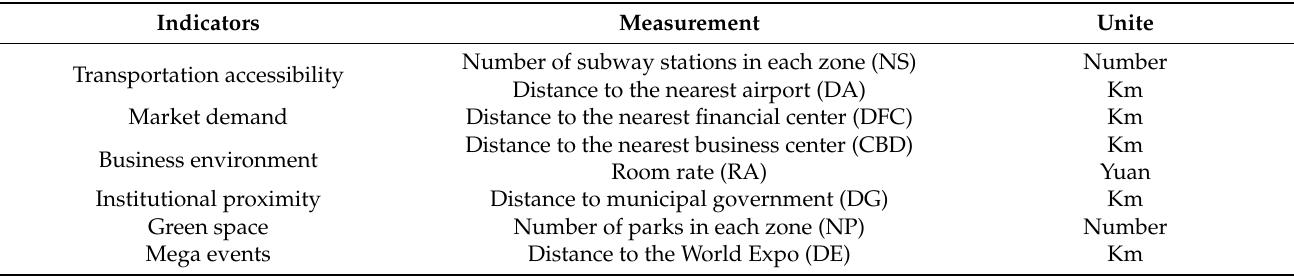
Table 1. The descriptive statistics of model variables.